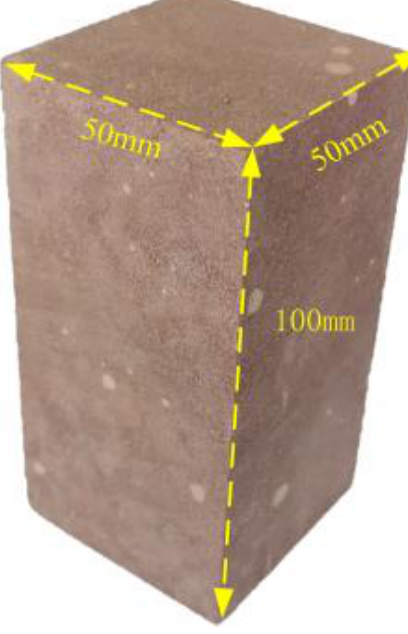
Figure 1. Red sandstone sample. Table 1. Detailed information about the test samples.